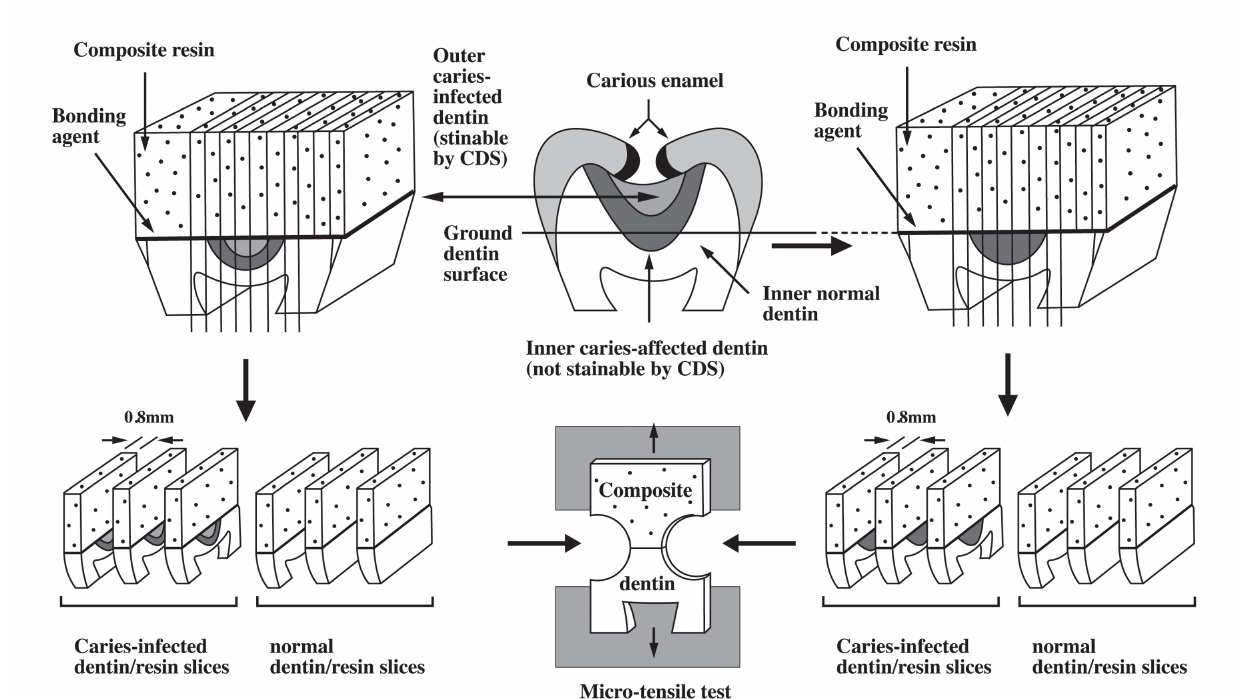
FIGURE 2 - Schematic showing how carious teeth were prepared for bonding and for micro-tensile test. CDS=caries detective solution ( Kuraray Medical Inc., Japan)